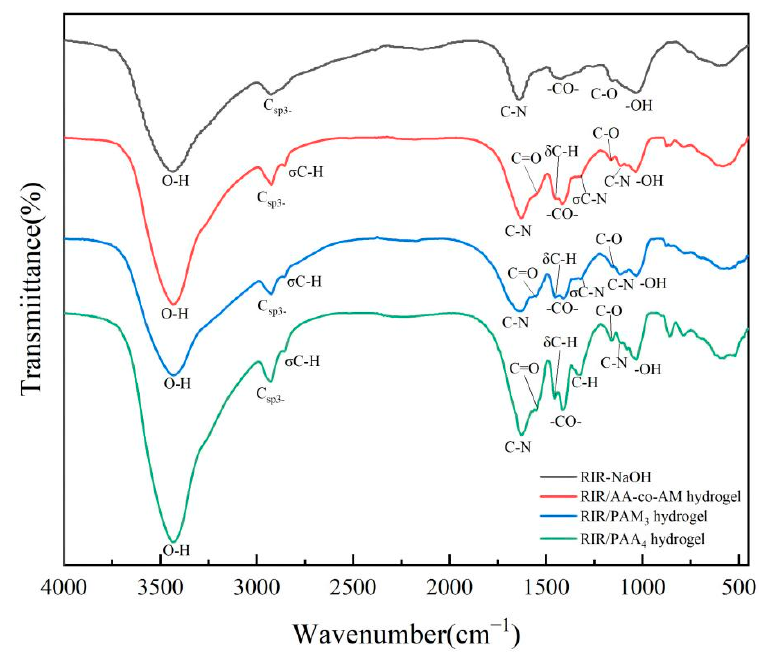
Figure 5. FTIR spectra of RIR-NaOH, RIR/AA-co-AM, RIR/PAM 3 and RIR/PAA 4.